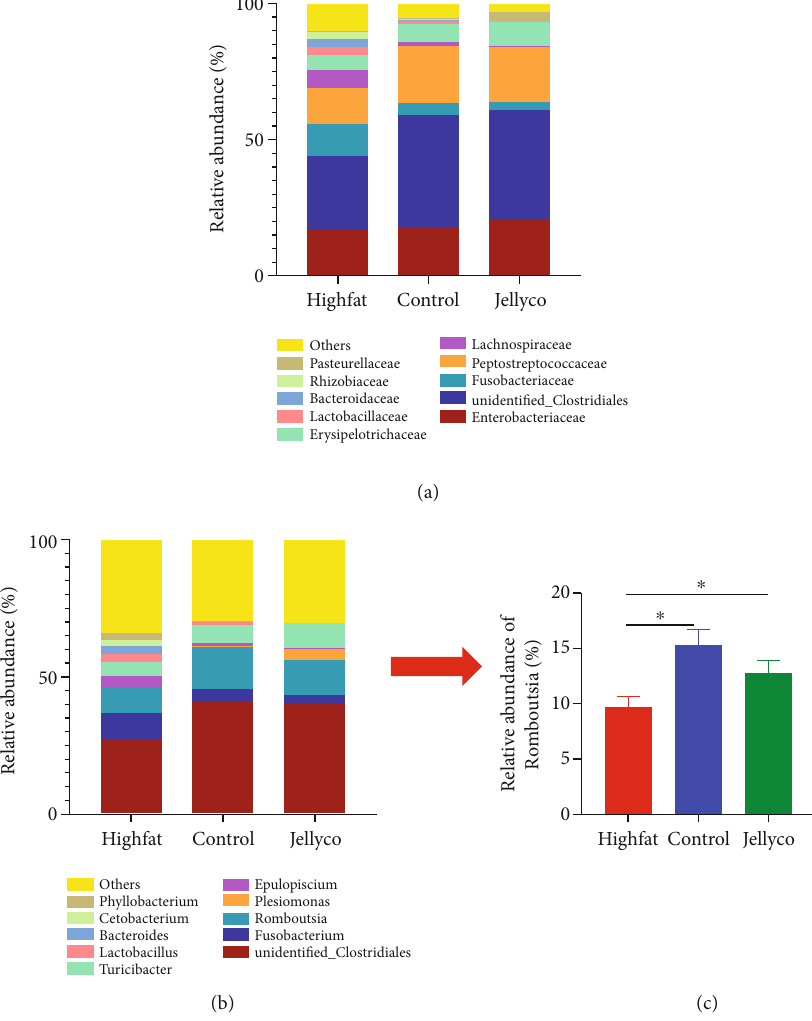
Figure 6: E ff ects of jelly fi sh collagen hydrolysate on relative abundance of the cecum microbial species in high-fat diet-fed mice. (a)Relative abundance of bacteria classi fi ed at a family-level taxonomy. (b) Relative abundance of bacteria classi fi ed at a genus-level taxonomy. (c) Relative abundance of Romboutsia . Data are expressed as means ± SEM , n = 7 . ∗ P < 0 : 05